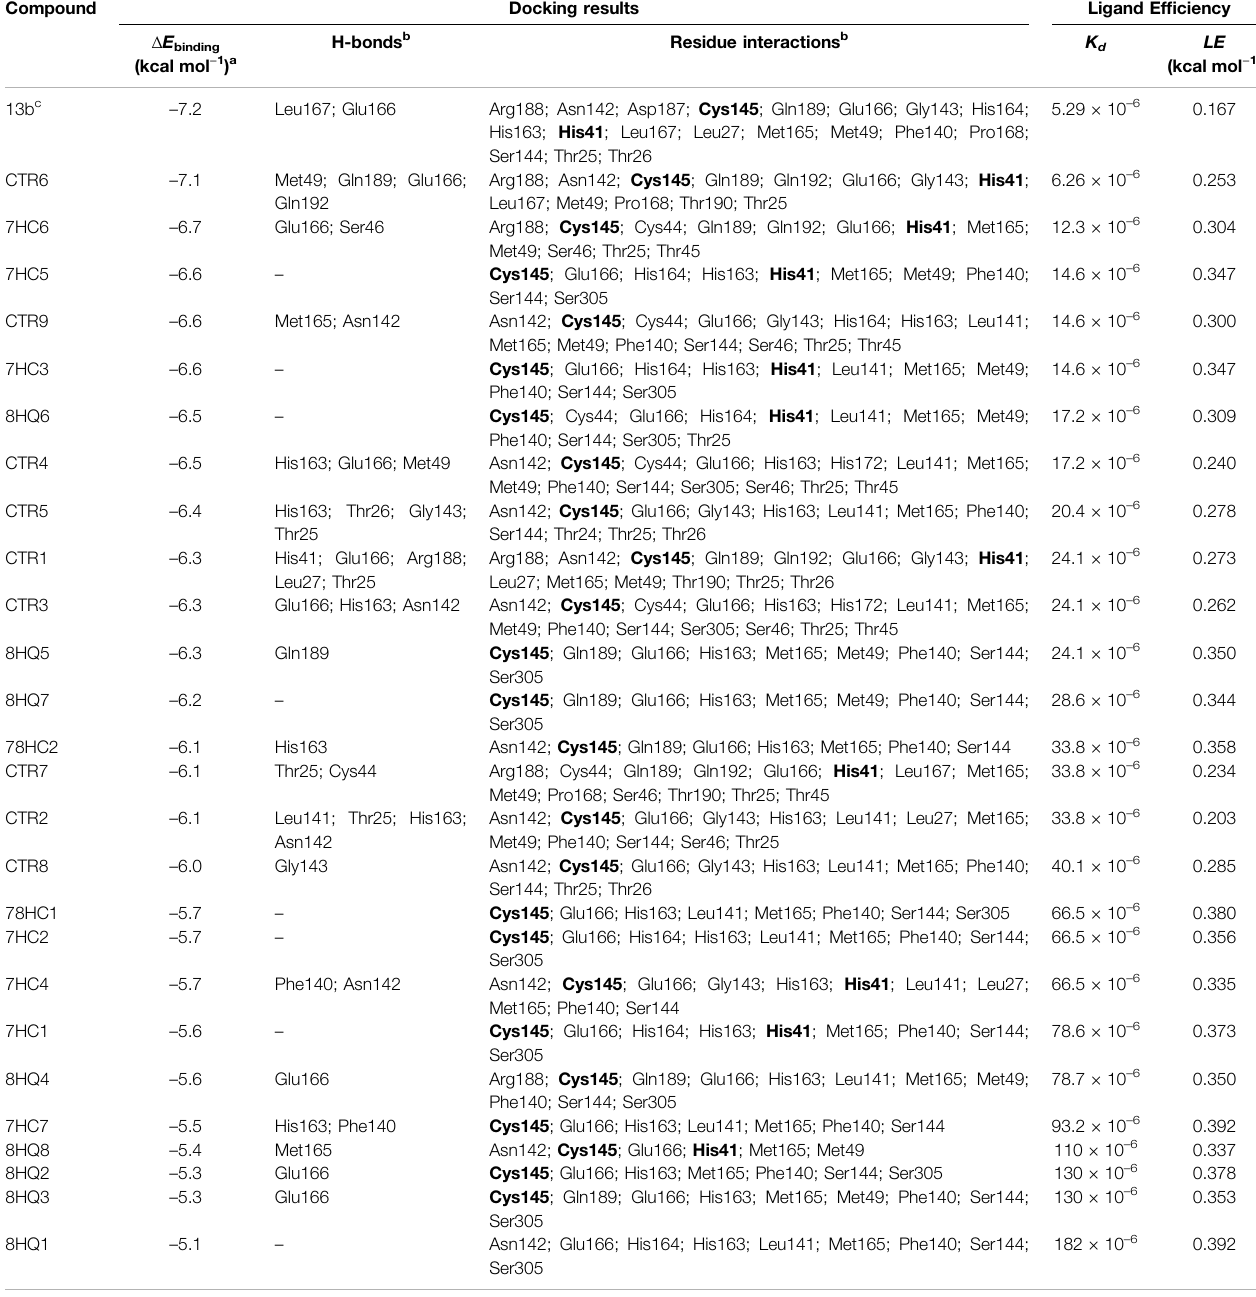
TABLE 2 | Molecular docking study between selected ligands and SARS-CoV-2 M pro . Intermolecular docking values, presented with their interaction energy ( Δ E binding ), H-bond residues, interacting residues are shown and Ligand ef fi ciency calculation for SARS-CoV-2 M pro complexes.